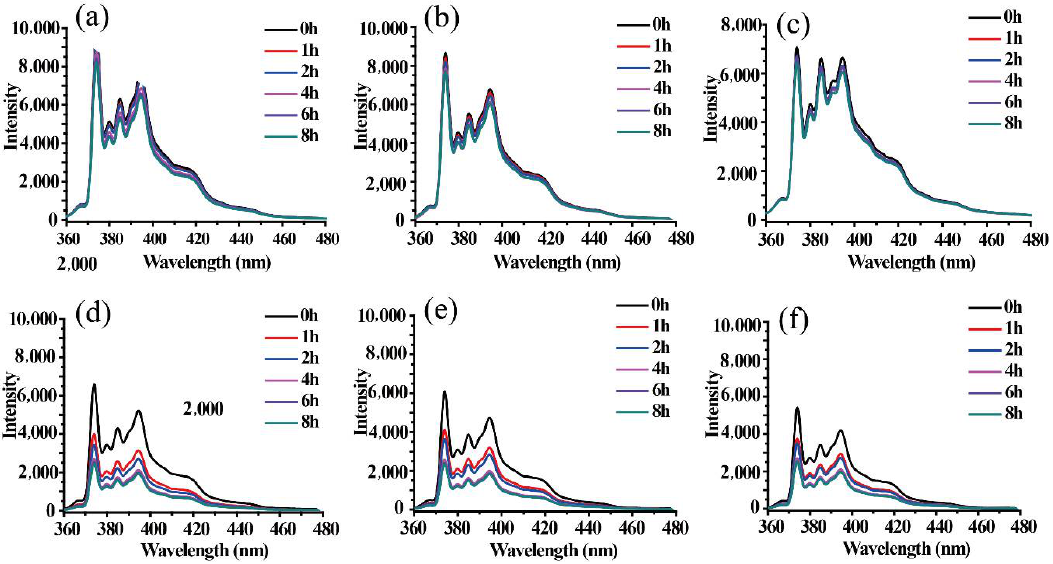
Figure 8. The fluorescent emission spectra of BCP1, BCP2 and BCP3 micelles encapsulated with pyrene in aqueous solution when pH = 7 ( a – c ) and pH = 3 ( d – f ) under an excitation wavelength of 336 nm along time.